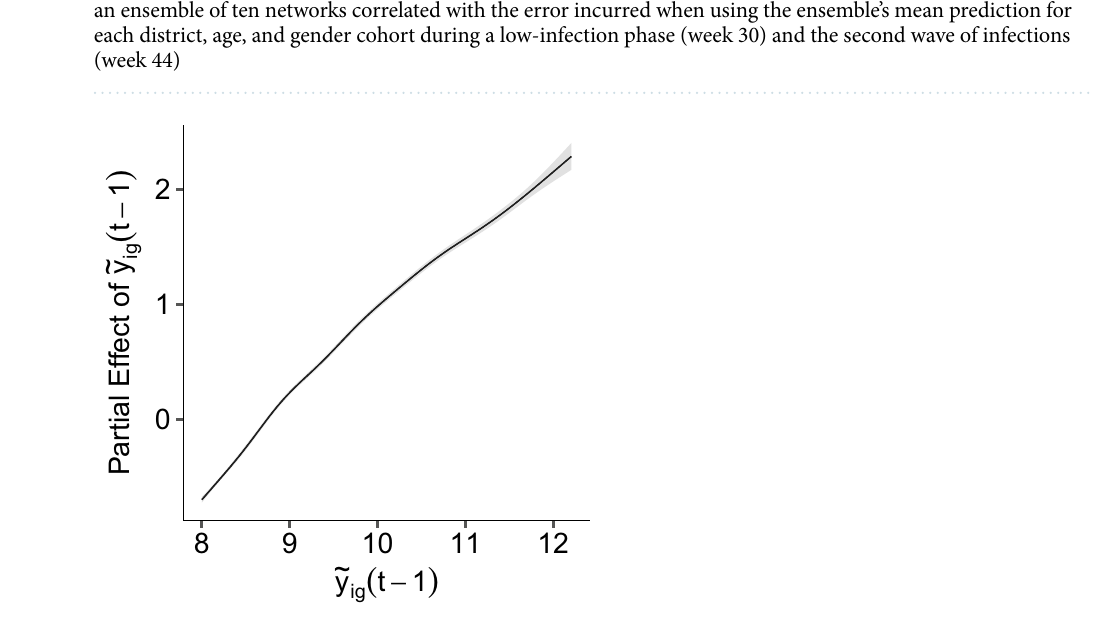
Figure 6. Estimated effect of lagged infection rate with corresponding confidence intervals for week week